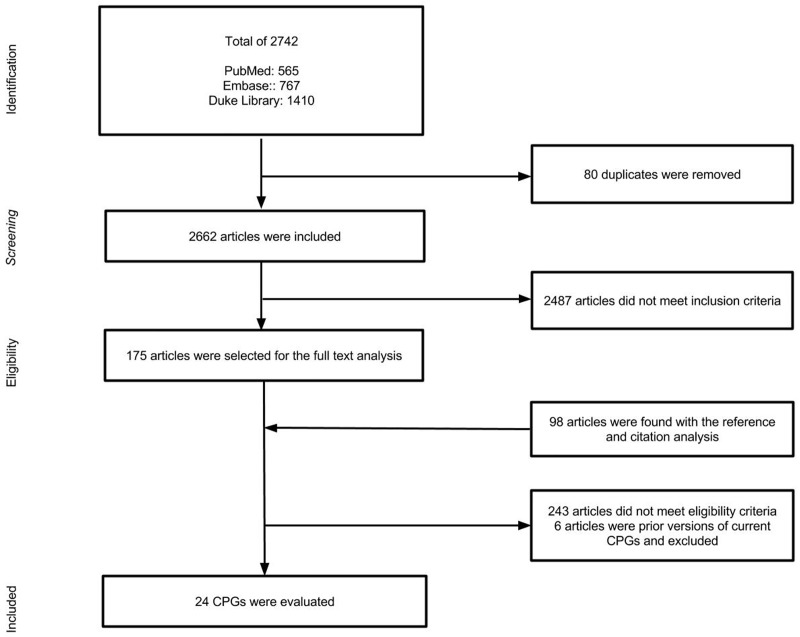
Study Flow Diagram.